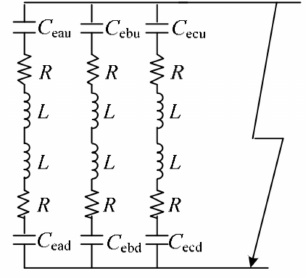
Figure 4. Equivalent circuit of capacitance discharge in the